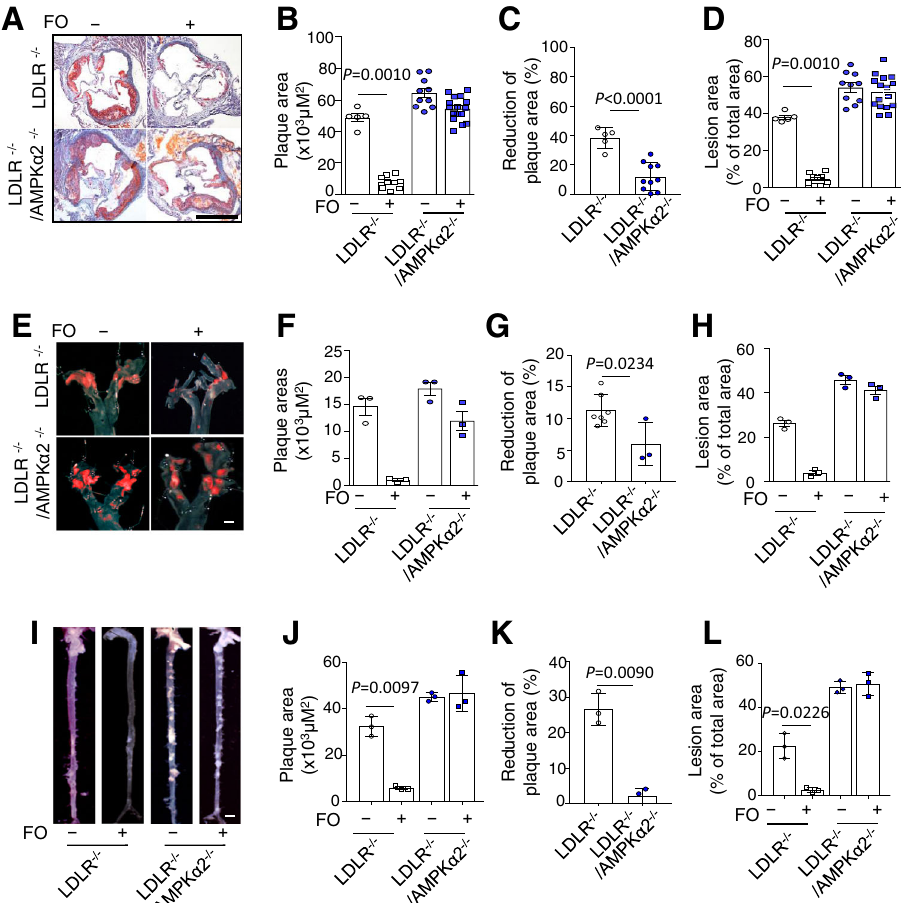
Fig. 1 | FO administration inhibited atherosclerotic plaque formation in LDLR − / − , but not LDLR − / − /AMPK α 2 − / − mice. LDLR − / − /AMPK α 2 − / − mice and their LDLR − / − littermates were fed a western diet (containing 0.21% cholesterol) for 12weekswithorwithout5%FOadministration. A , E , I RepresentativeimagesofOil Red O staining from each of four groups: LDLR − / − ( n =11), LDLR − / − +FO ( n =17), LDLR − / − /AMPK α 2 − / − ( n =16), and LDLR − / − /AMPK α 2 − / − +FO ( n =22). Scale bar,